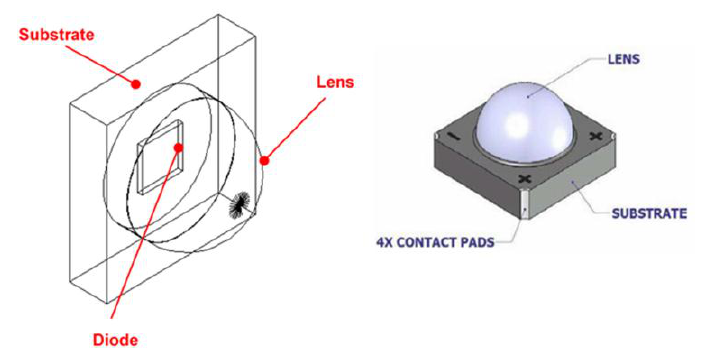
Figure 2. Light-emitting diodes (LEDs) model in Figure 2. light-emitting diodes (LEDs) model in simulation. Figure 2. light-emitting diodes (LEDs) model in simulation.